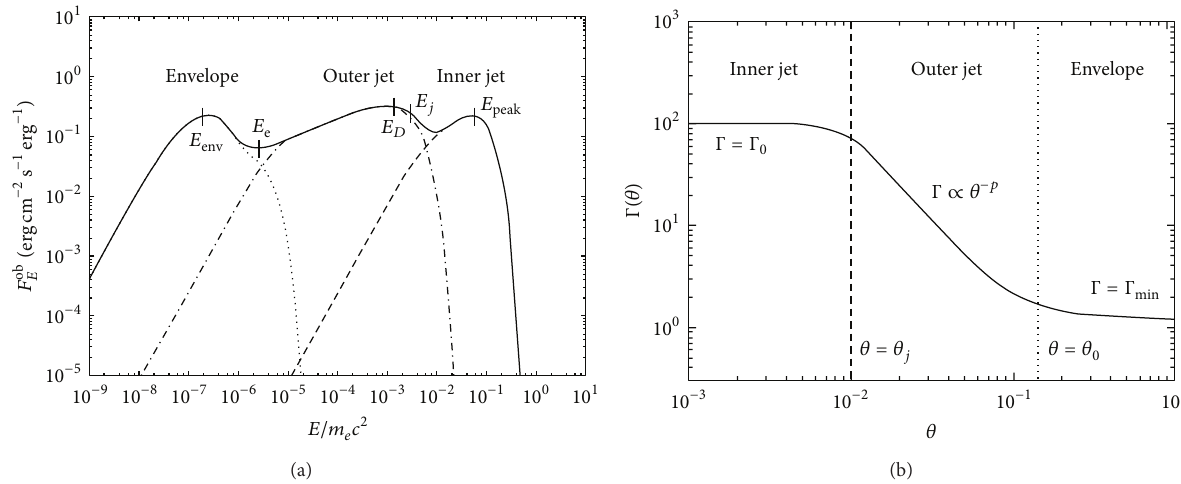
Figure 19: (a) The expected (observed) spectrum from a relativistic, optically thick outflow. The resulting spectra does not resemble the naively expected “Planck” spectrum. Separate integration of the contributions from the inner jet (where Γ ≈ Γ 0 ), outer jet (where Γ drops with angle), and envelope is shown with dashed, dot dashed, and dotted lines, respectively. (b) The assumed jet profile. Figure taken from Lundman et al.